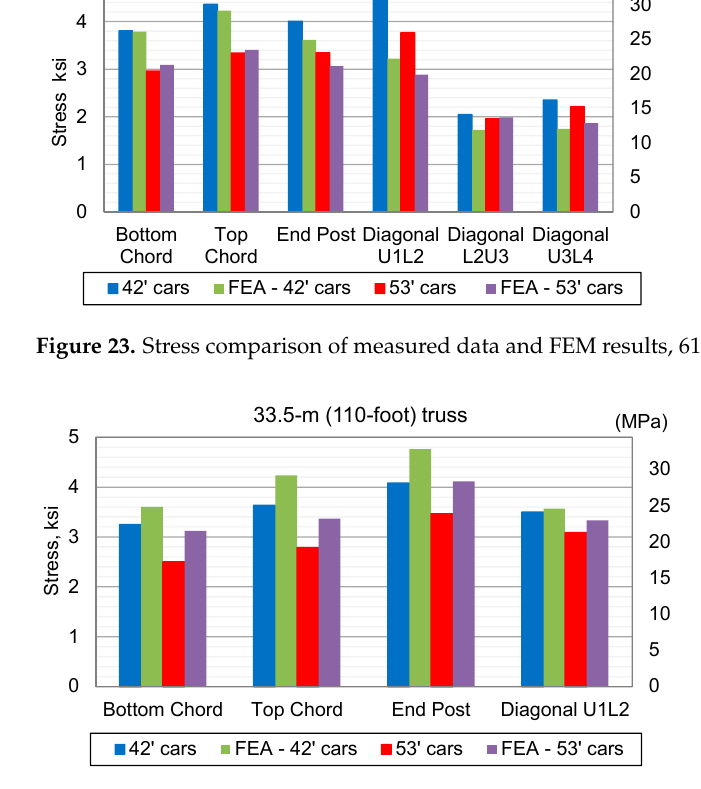
Figure 24. Stress comparison of measured data and FEM results, 33.5 ‐ m (110 ‐ ft) span.